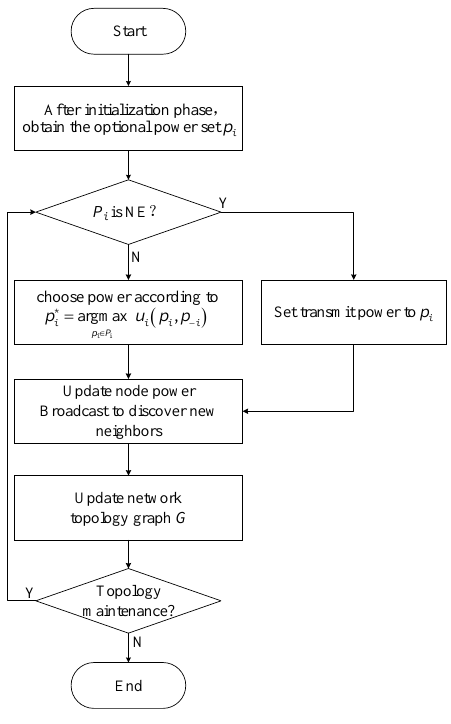
Figure 1. Flowchart of power